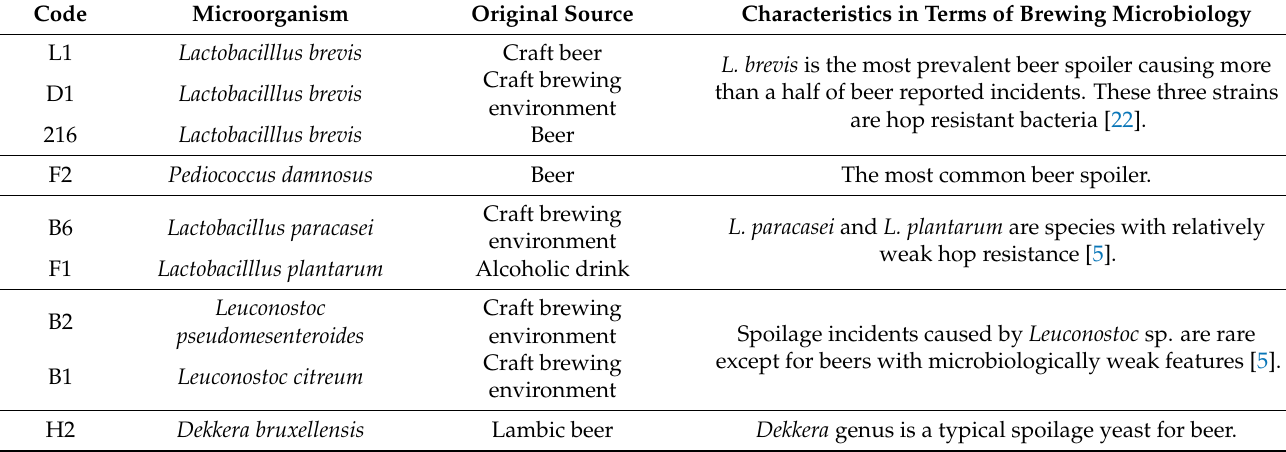
Table 1. List of potential beer spoilage microorganisms used in this